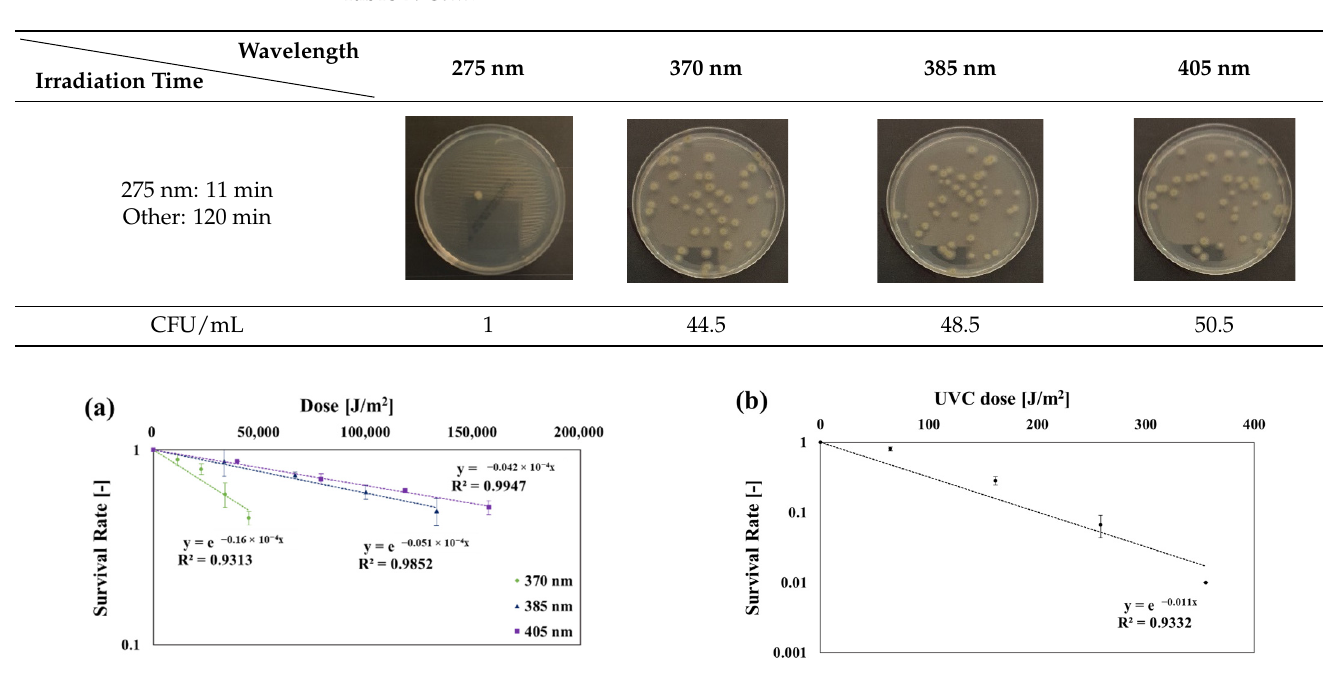
Figure 7. Inactivation curves of C. cladosporidides at each dose and wavelength: ( a ) 370, 385, 405 nm; ( b ) 275 nm.